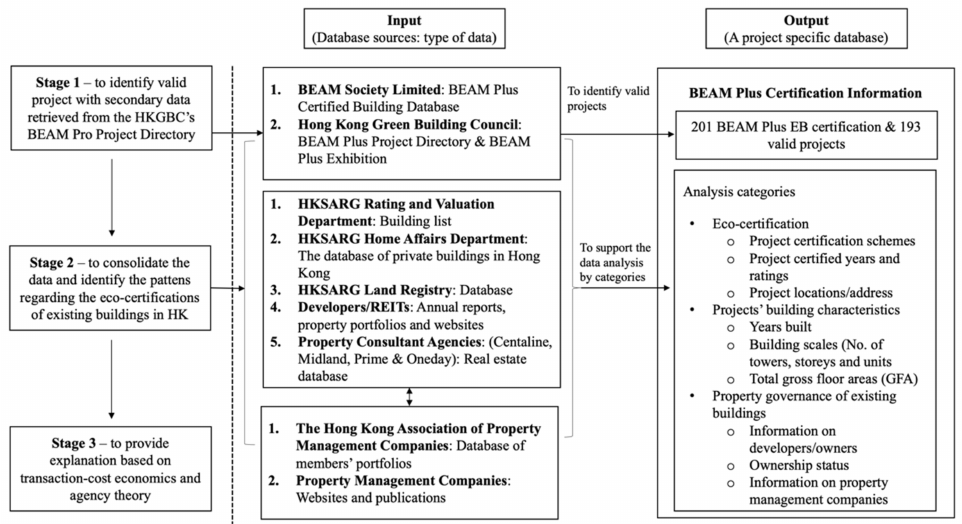
Figure 1. Research design, data retrieving, and analysis process. To prevent ambiguity, the term “buildings” in the results section refers to “building projects” (the building or a group of buildings) with respect to BEAM Plus certification